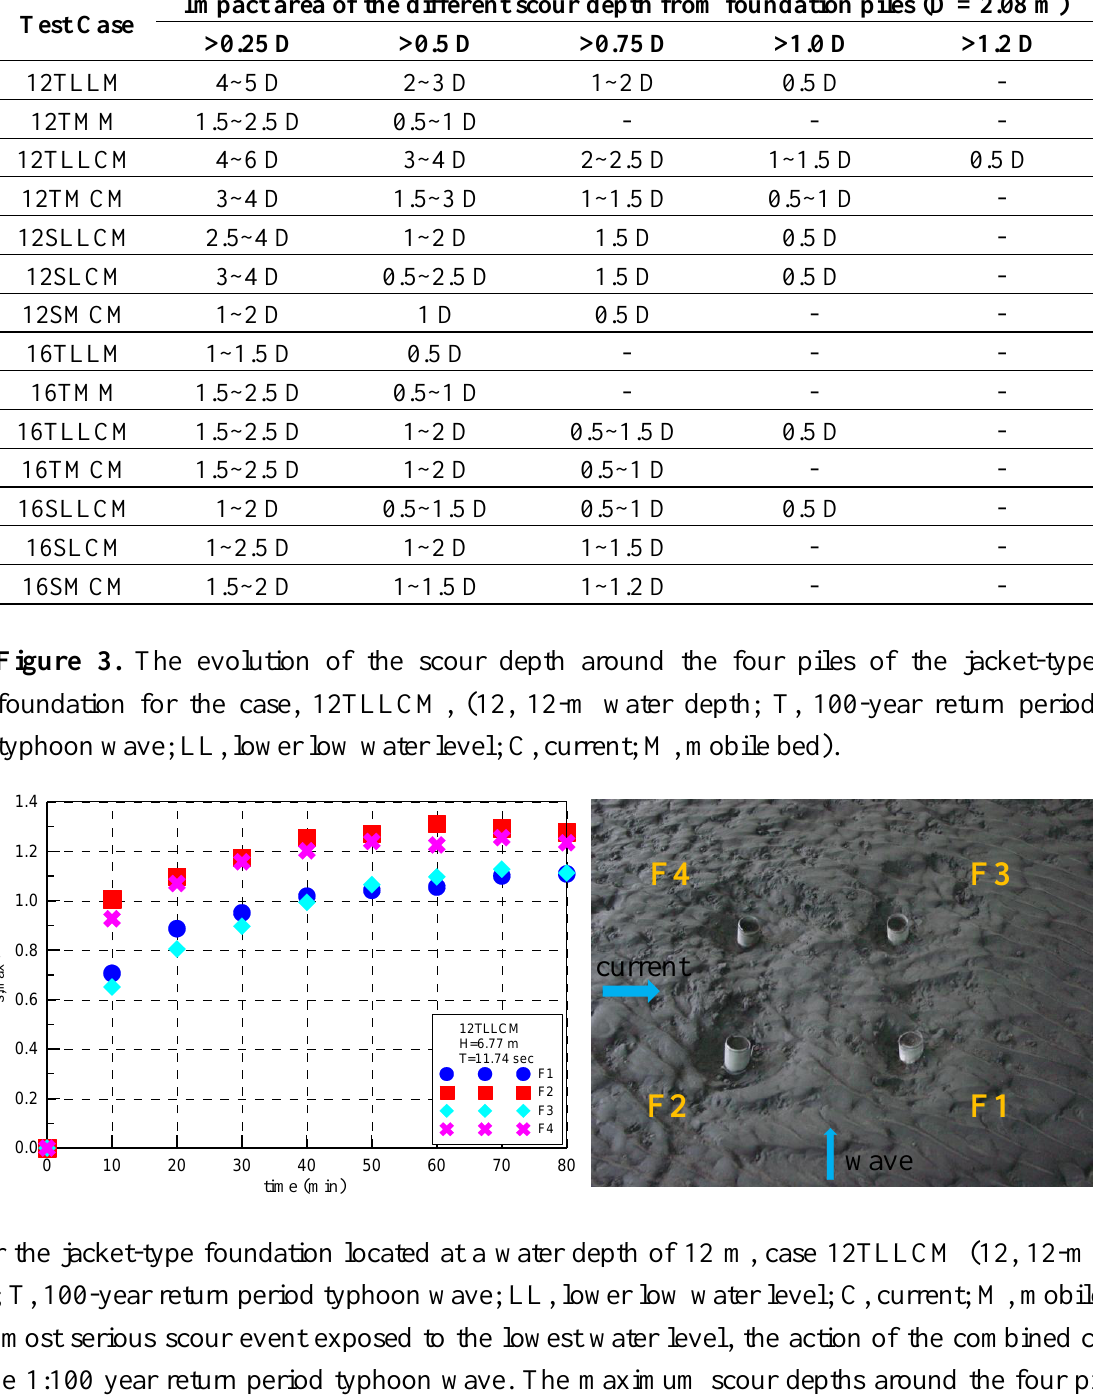
Table 3. The potential impact erosion areas around the jacket-type foundation (a water depth of 12 m and 16 m) under different hydrodynamic conditions.